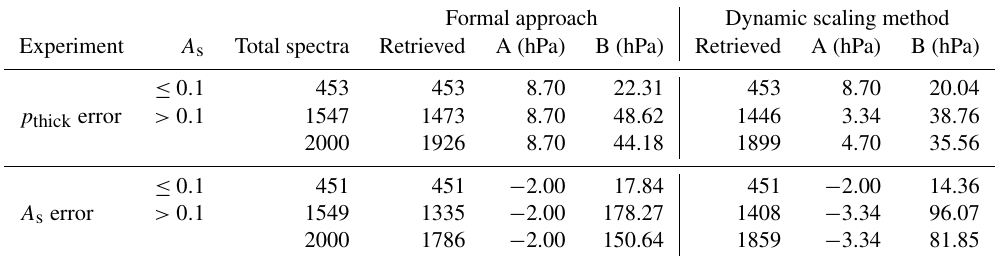
Table 2. Results of the retrieval accuracy of z aer from sensitivity analyses, split into two classes of A s . The number of successful retrievals are reported in the “retrieved” column. Columns with the heading A are the locations of the peak of ϕ , representing the z aer bias value with the highest frequency of occurrence. Those with B are the full-width at half maximum of ϕ , representing the spread of z aer biases. Formal approach Dynamic scaling method Experiment A s Total spectra